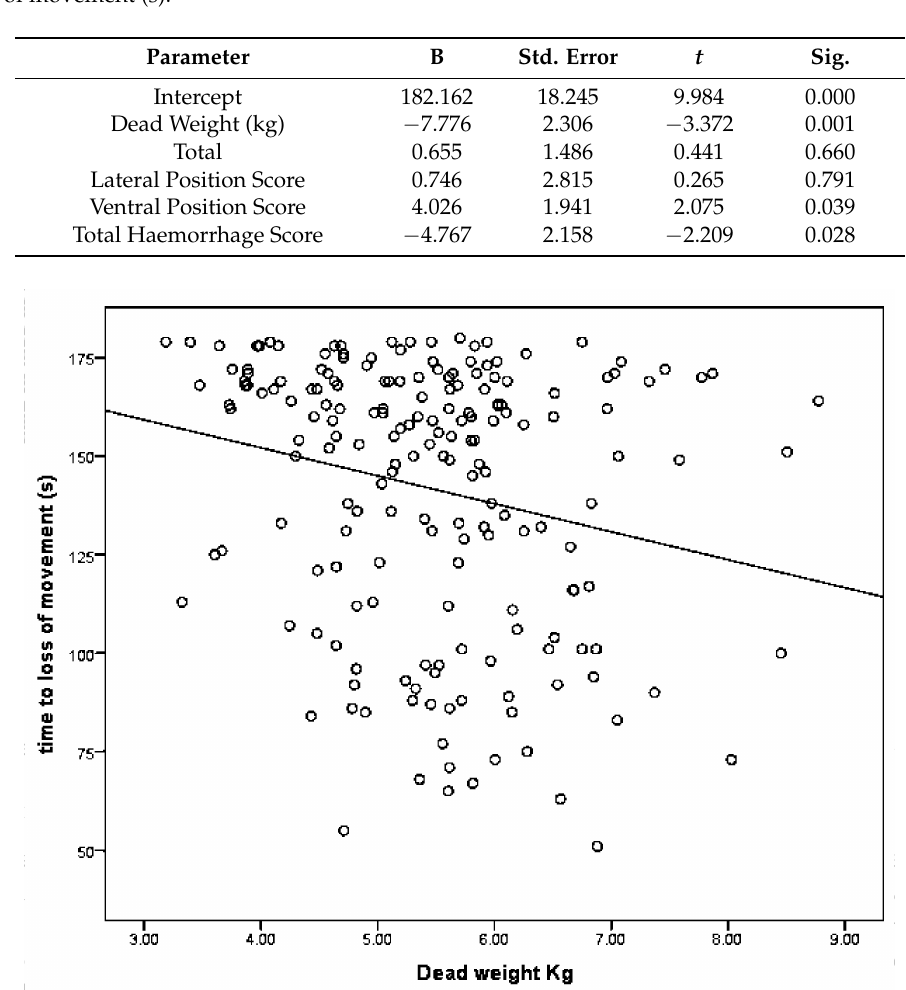
Table 2. Parameter estimates from the general linear model (GLM) testing for an effect of dead weight (kg), total damage score, lateral and ventral shot position score and total haemorrhage score on time to loss of movement (s).